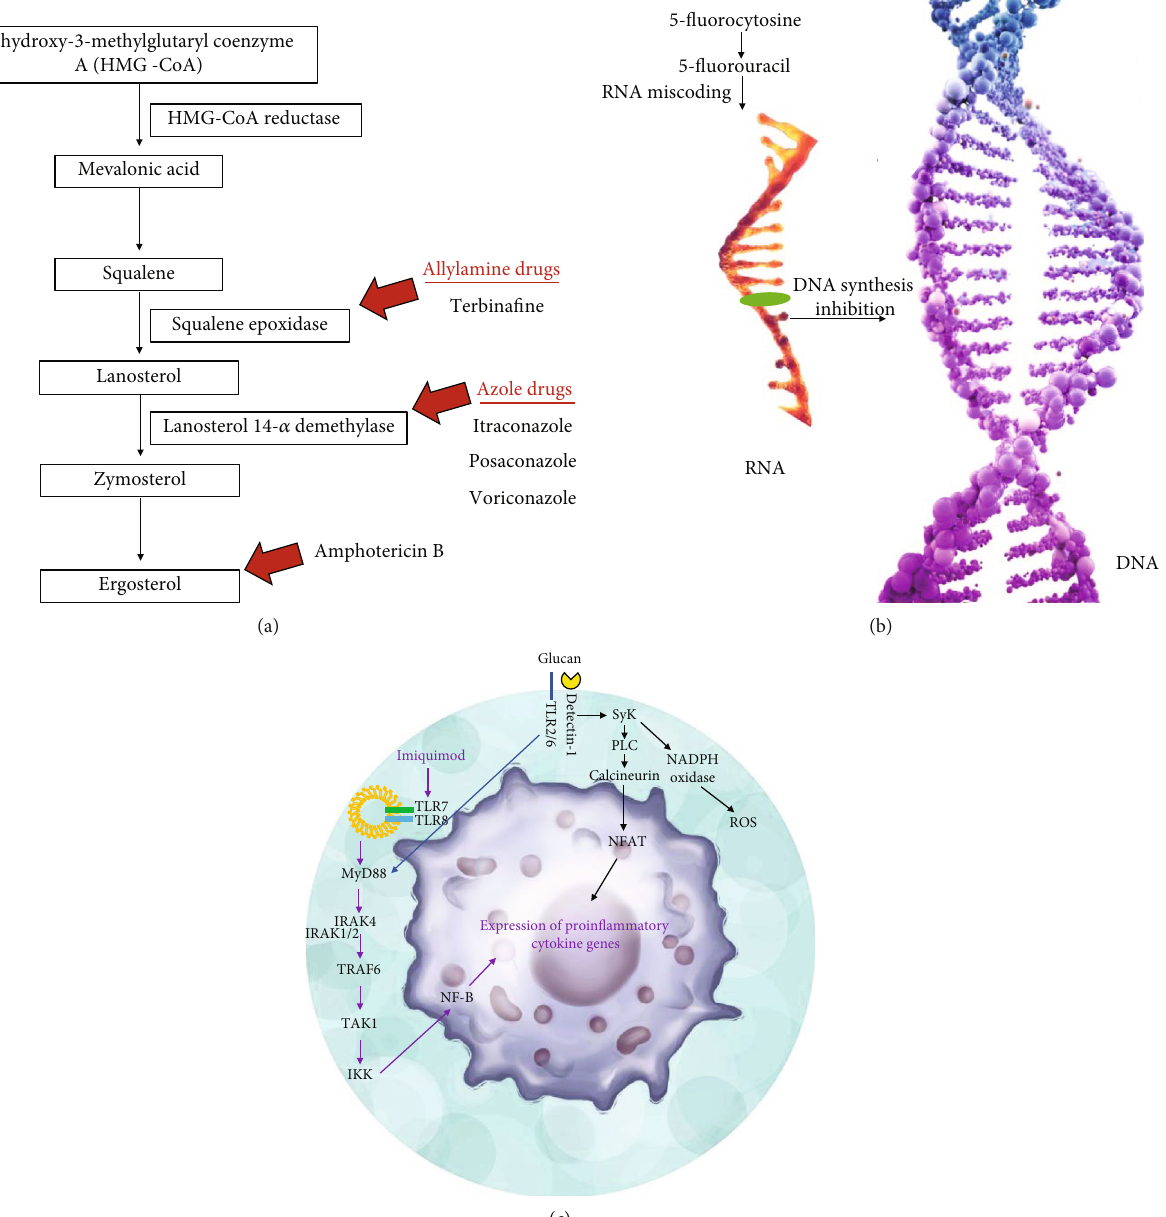
Figure 7: Drugs used in the treatment of CBM. (a) This scheme shows the biosynthesis of ergosterol, which is one of the main components of cell membranes of fungi, as well as enzymes that common drugs target, interrupting the production of ergosterol. (b) Some antifungal drugs, such as 5- fl uorocytosine, inhibit DNA synthesis in etiologic agents of CBM. (c) Some molecules, such as imiquimod and glucan, have been used to stimulate the immune response of hosts; imiquimod is an agonist of TLR7/8 and glucan in a pathogen-associated molecular pattern capable of binding to the TLR2/6 and detectin-1 receptor. In both cases, such molecules trigger the production of proin fl ammatory cytokines from the Th1 immune